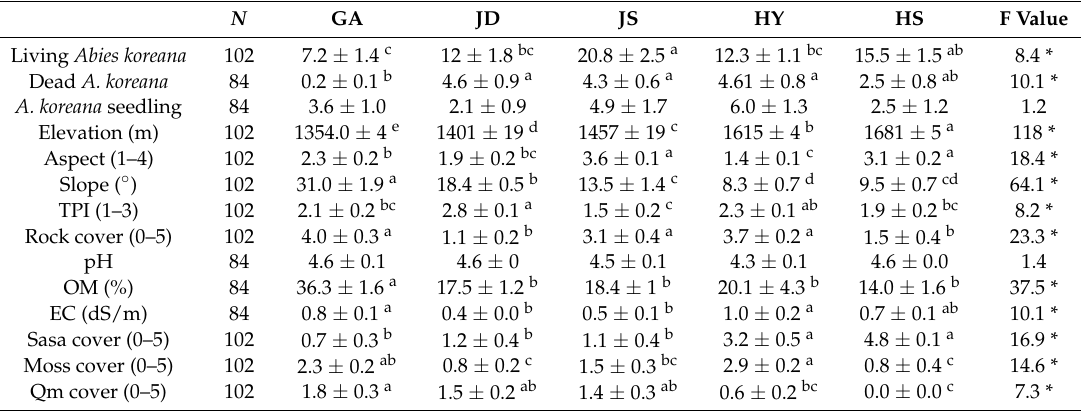
Table 1. Descriptive statistics of the Korean fir density and environmental variables. N GA JD JS